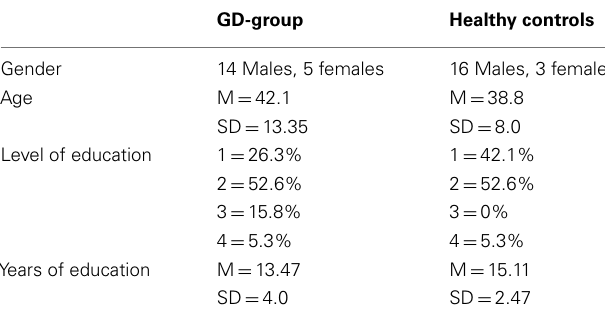
Table 1 | Characteristics of subjects